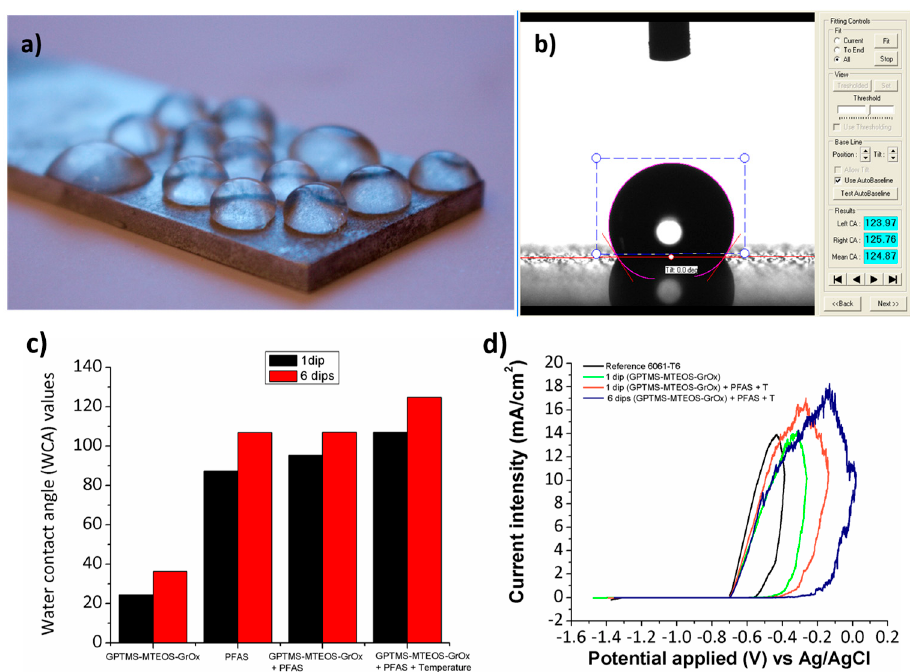
Figure 6. ( a ) Droplet of water onto aluminum substrate for sample of 6 dips of GPTMS-MTEOS and PFAS, respectively; ( b ) Contact angle value of the sample thermally treated; ( c ) evolution of the water contact angle value as a function of the number of dips and thermal treatment; ( d ) Cyclic polarization curves in 3.5% NaCl solution for the different samples of study. Reproduced from [63] with permission; Copyright Elsevier 2017.